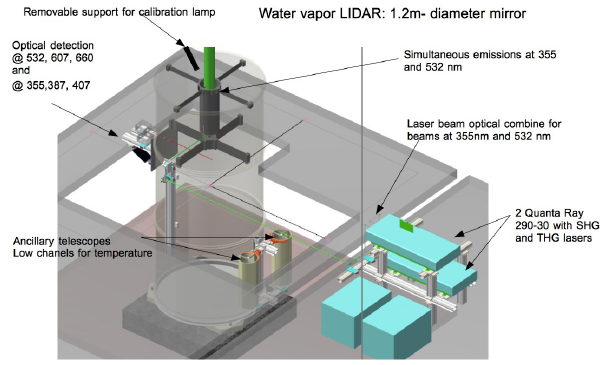
Fig. 14. Representation of the design of the future lidar imple- Figure 14. Representation of the design of the future lidar implemented at the Reunion Island 3 mented at the Reunion Island altitude altitude observatory. 4